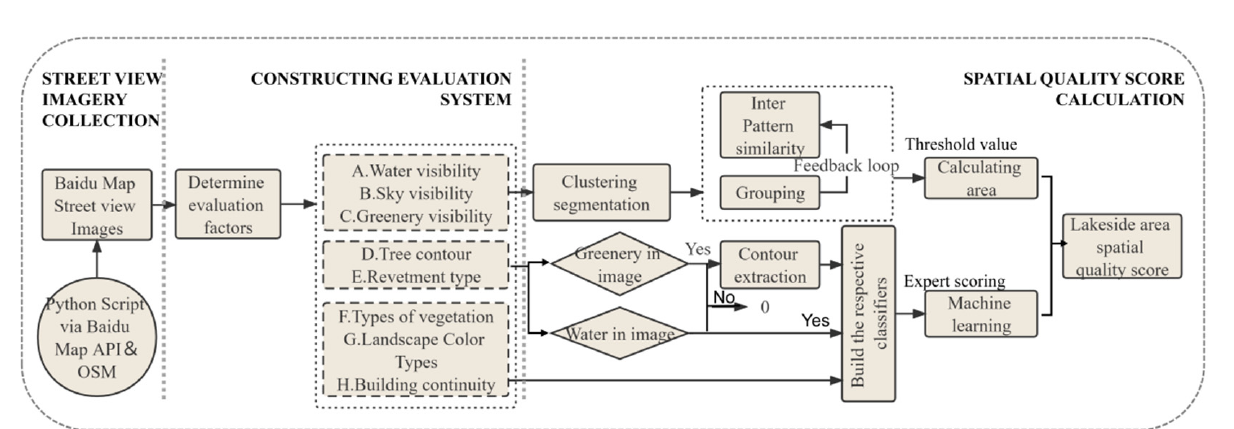
Table 3. Evaluation system for space quality of the lakefront area.